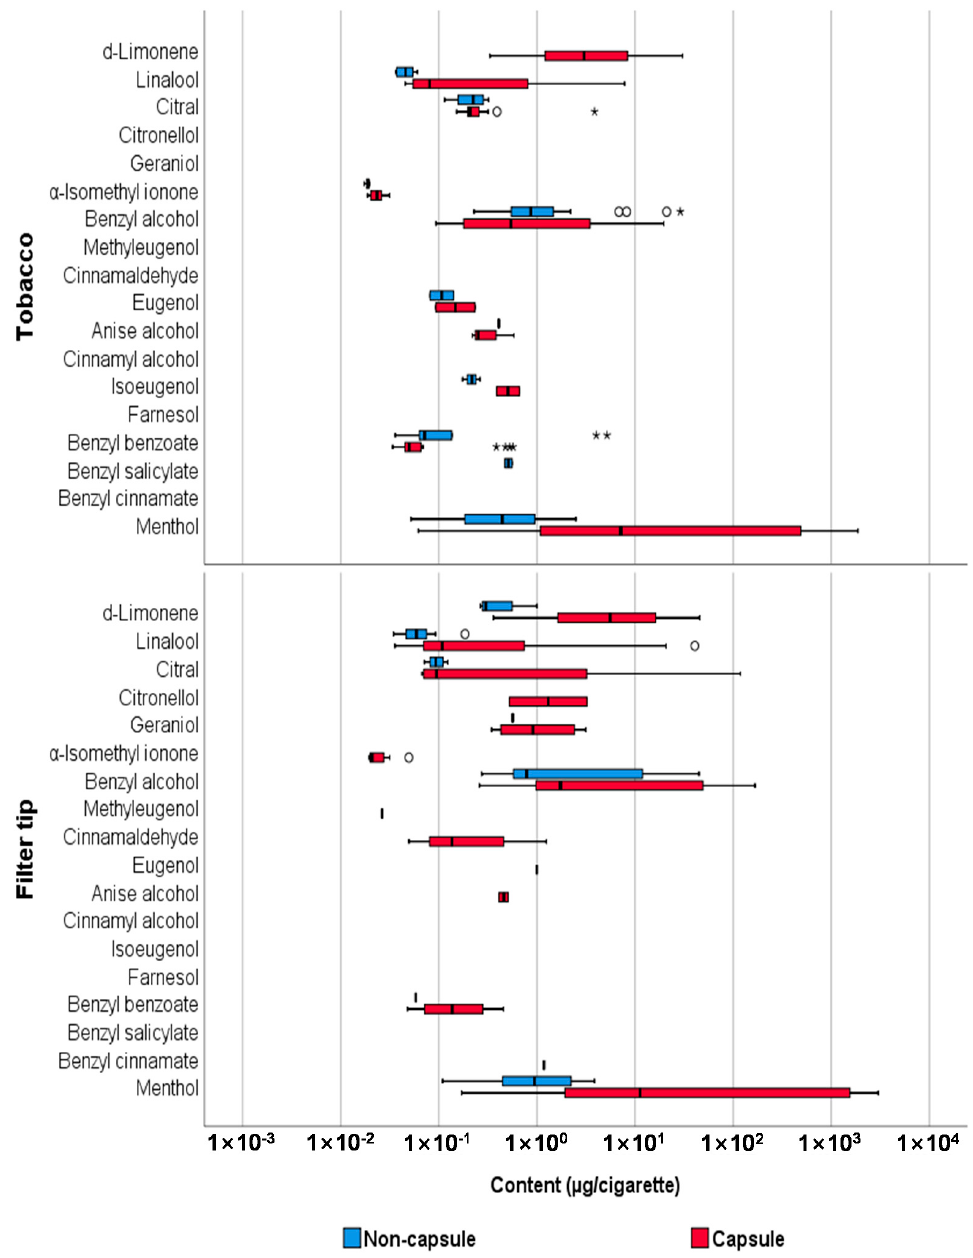
Figure 3. Comparison of content ( µ g/cigarette) of flavoring agents between capsule and non-capsule cigarettes. The thick line inside the box represents the median value, and the box edges represent the 25th percentile (Q1) and 75th percentile (Q3). The whiskers represent the minimum and maximum values (excluding outliers). The circles ( ○ ) represent the outliers (above Q3 + 1.5 × interquartile range), and the stars (*) represent the extreme values (above Q3 + 3 × interquartile range).